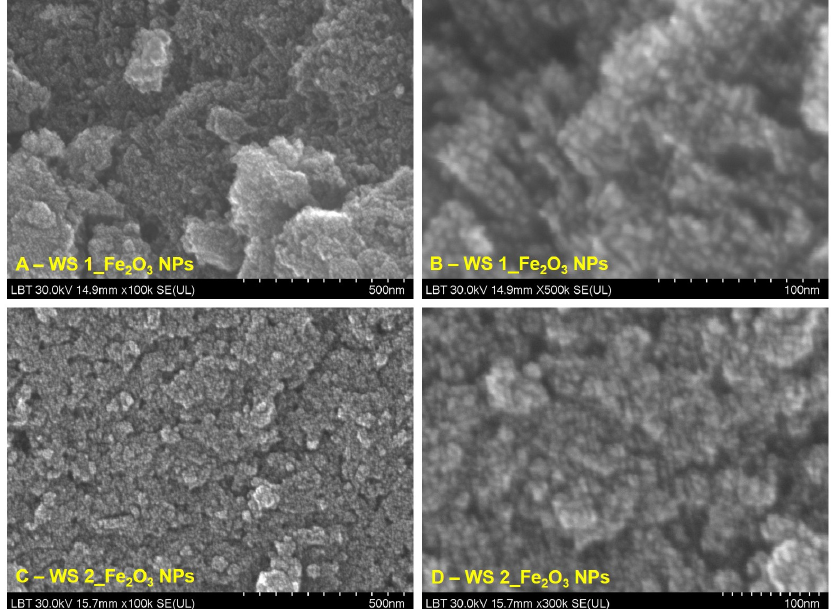
Figure 6. SEM images of IONPs obtained from wormwood stems aqueous extract (WS 1–at 80 °C and WS 2–at 25 °C), at different orders of magnitude: ( A , C ) 500 nm scale bar, ( B , D ) 100 nm scale bar.